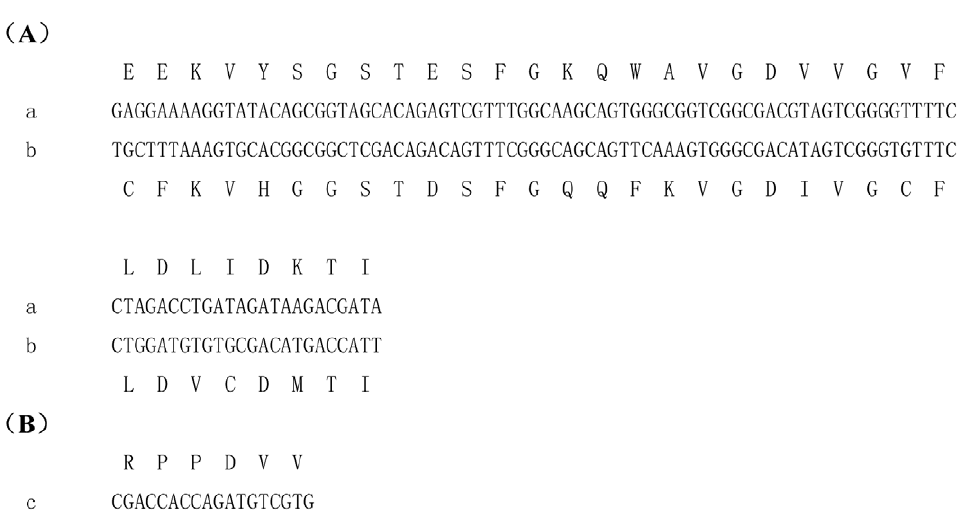
Figure 5. Nucleotide and inferred amino acid sequences of alternative exons in the CmRyR gene.